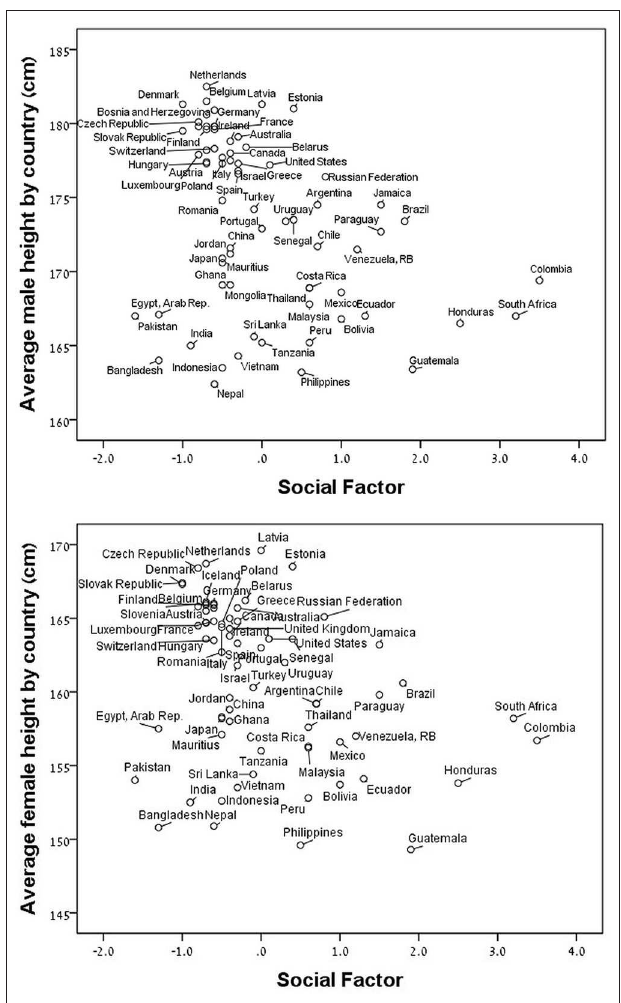
FIGURE 2 | Average height by country as a function of the social factor (Z-score) for males (upper panel: r = − 0.35, p < 0.0001) and for females (lower panel; r = − 0.32 p < 0.005).